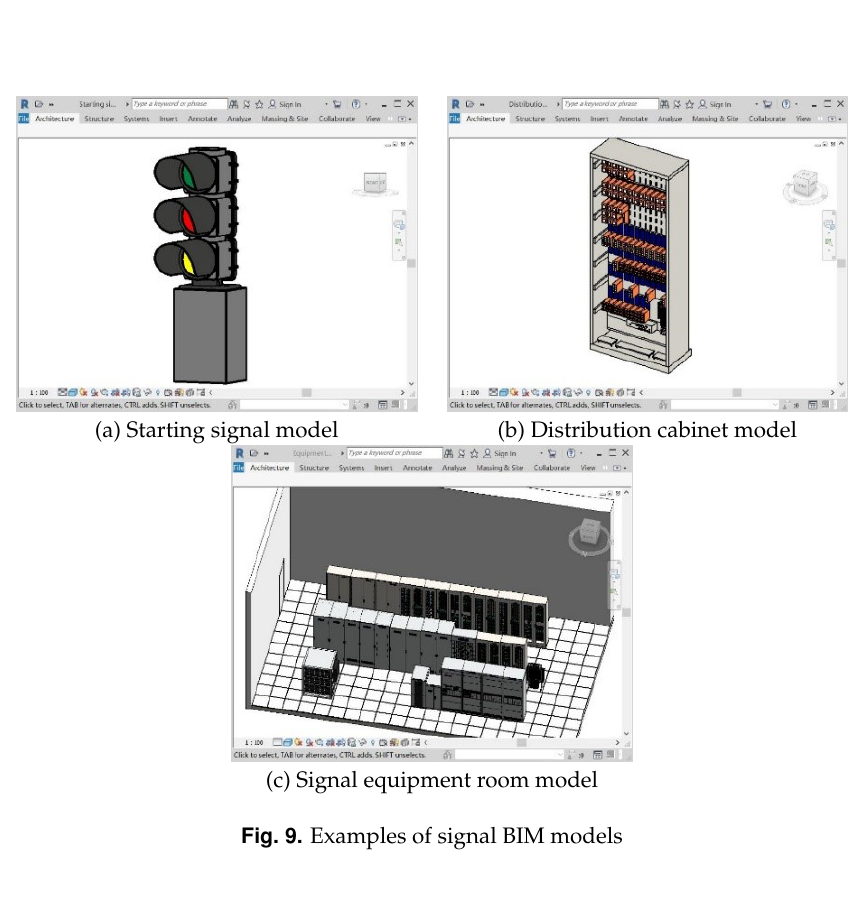
Fig. 9. Examples of signal BIM models